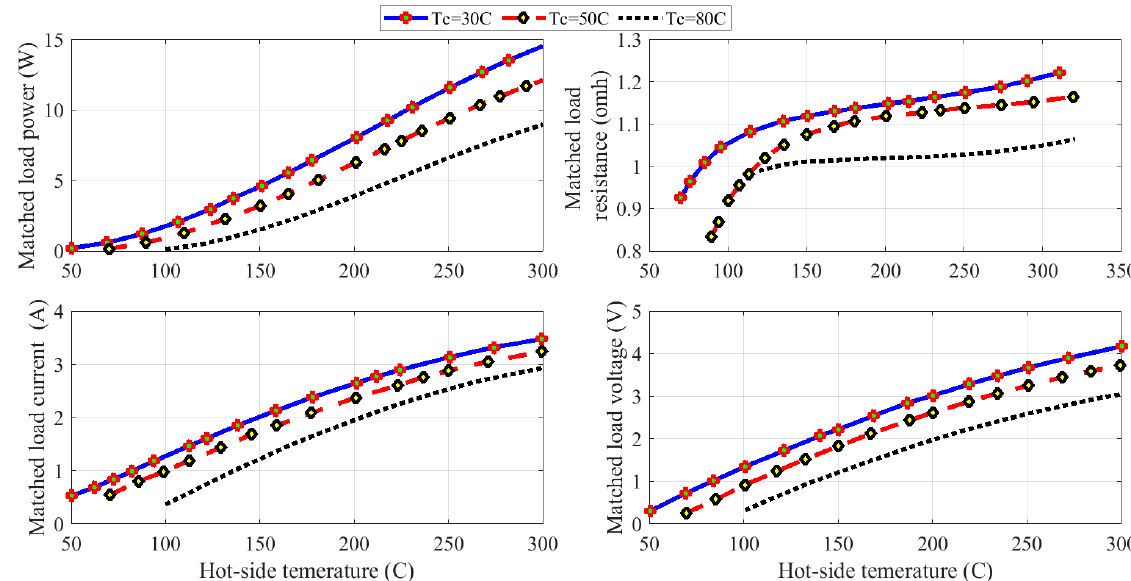
Figure 5. Matched load parameters when varying the hot and cold side temperature values.